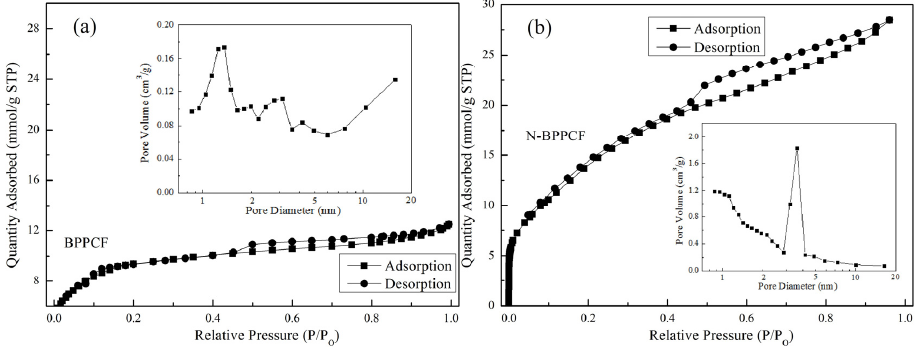
Figure 3. Nitrogen sorption isotherms of ( a ) BPPCF and ( b ) N-BPPCF, and the corresponding pore size distribution (insets). Table 1. Specific surface area, porosity parameters and nitrogen content of the BPPCF and N-BPPCF samples. In the table, S BET stands for BET surface area, while BJH pore diameter, total pore volume and meso-pore valume were abbreviated as D BJH , V TPV and V meso .